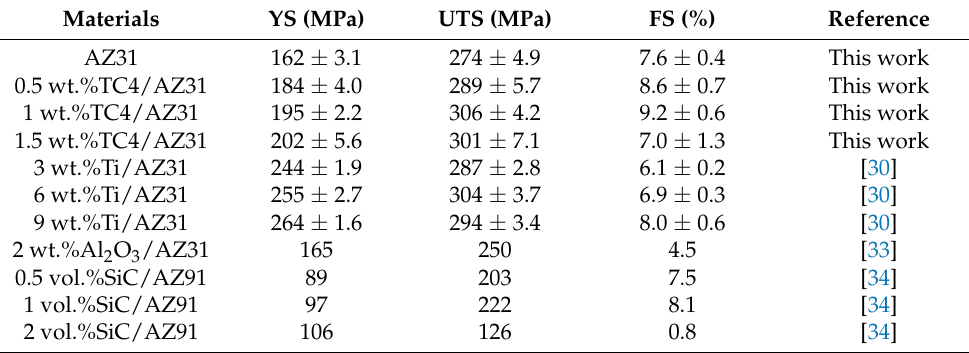
Figure 11. Stress – strain curves of as-extruded TC4/AZ31 composites in tensile tests. Figure 11. Stress–strain curves of as-extruded TC4/AZ31 composites in tensile tests. Table 2. Tensile properties of different magnesium matrix